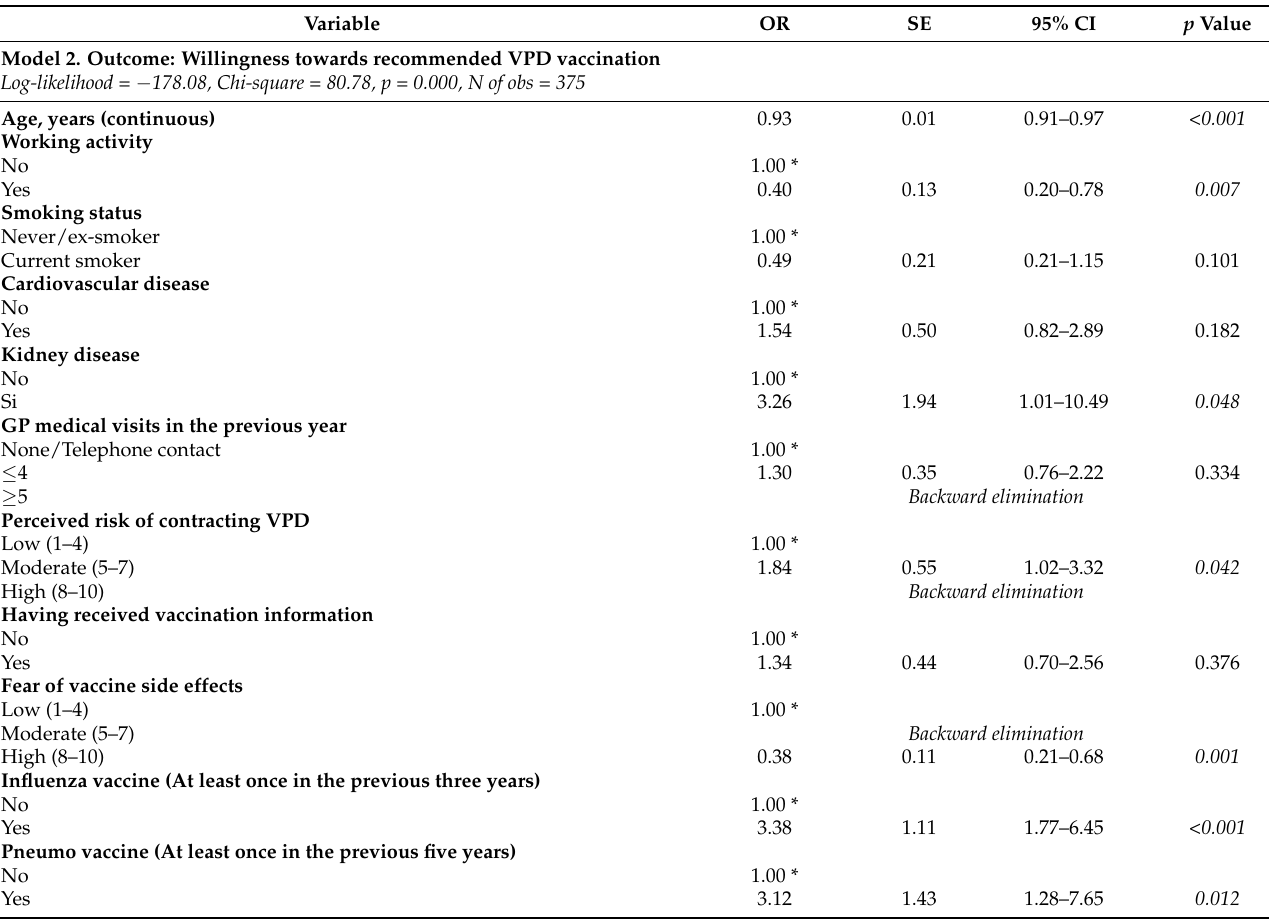
Table 4. Multiple logistic regression analysis results to estimate the associations between willingness to receive recommended VPD vaccination in frail subjects and a variety of